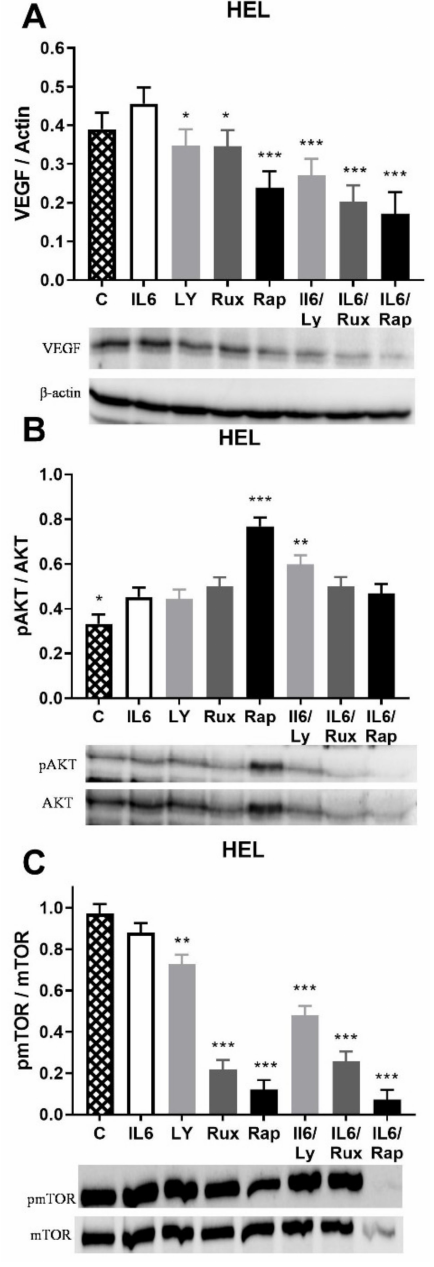
Figure 2. Interleukin-6 (IL-6) induction of angiogenic factors and related signalling pathways in JAK2V617F positive human erythroleukemic (HEL) cells. Densitometry revealed protein expression determined by Western blotting and presented as a ratio to Actin of total protein levels. The HEL cells were treated for 1 h by 20 ng/mL IL-6 with or without 1 µ M JAK1/2 inhibitor Ruxolitinib, 5 µ M PI3K inhibitor LY294002 and 100 ng/mL mTOR inhibitor Rapamycin and levels of ( A ) VEGF, ( B ) phospho AKT, and ( C ) phospho mTOR were determined. Values are mean ± SEM ( n = 3). * p < 0.05, ** p < 0.01, *** p < 0.001 vs. IL-6. * p < 0.05, ** p < 0.01, *** p < 0.001 vs. VEGF vs.